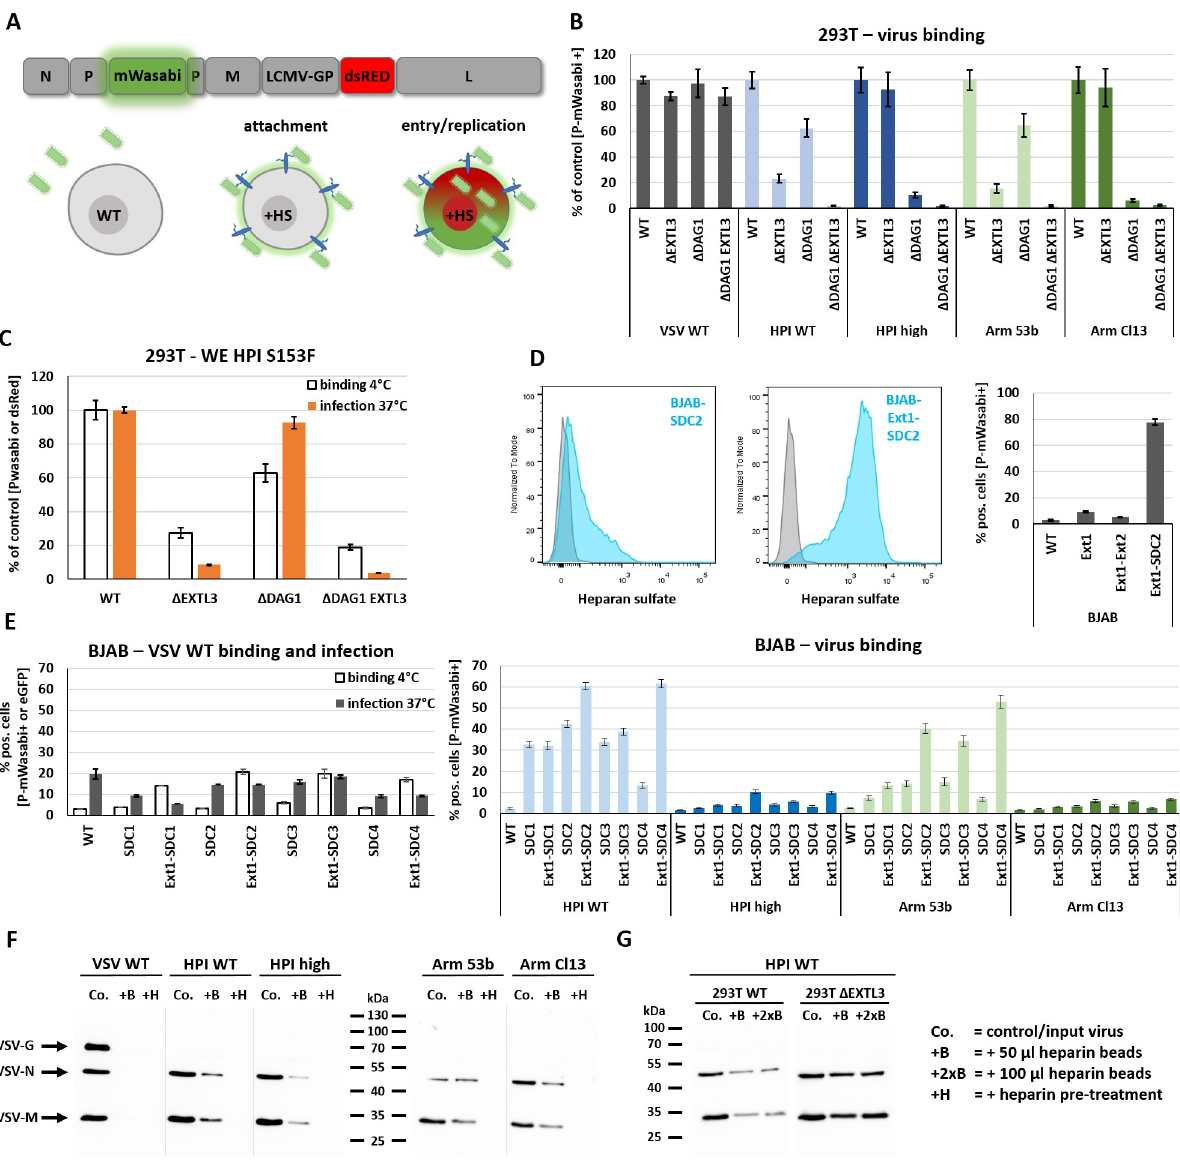
Fig 6. Proteoglycan expression restores HS expression on cell surface of BJAB cells and enables LCMV GP mediated virus attachment. (A) Schematic overview of a directly labelled VSV-GP construct encoding a P-mWasabi fusion construct and dsRed on 5 th position that allows to distinguish between attachment and virus entry/replication. Virus attachment was quantified by flow cytometry analysis. For attachment analysis, cells were incubated with directly labelled VSV-P-mWasabi-G or -GP variants for 30–45 min at 4˚C in a total volume of 50 μ l PBS or complete growth medium. Before measurement, samples were washed twice with PBS. Created with BioRender.com. (B) VSV-G and LCMV-GP mediated attachment of low or high affinity variants to 293T WT, Δ EXTL3 , Δ DAG1 , and Δ DAG1 EXTL3 cells. (C) Binding (4˚C for 30 min) and infection (MOI 1, 37˚C, 14 h p.i.) assay with 293T WT and variants for WE HPI S153F carrying the low affinity mutation described for WE2.2. (D) Flow cytometry analysis of HS expression in BJAB cells stably transduced with SDC2 or the combination of EXT1-SDC2 (left). GP-mediated (HPI WT) virus attachment to BJAB cells stably transduced with EXT1, EXT1-EXT2 or EXT1-SDC2 (right). (E) Different members of the syndecan family (SDC1–4) were tested alone or in combination with EXT1 in BJAB cells for their ability to enable VSV-G or LCMV-GP mediated attachment and infection. (F) In a pulldown assay, 50 μ l heparin-coated agarose beads (+B) were incubated with purified VSV WT or VSV-GP variants at 4˚C for 4 h under constant rotation. After four washing steps with PBS + 0.2% BSA, the beads were resuspended in 100 μ l RIPA buffer, incubated for 20 min on ice and boiled at 95˚C for 10 min after the addition of 4x SDS loading buffer. Western blotting was performed with anti-VSV serum (detecting VSV-G, -N, -M). co. = same amount of input virus used for incubation with heparin-coated agarose beads. (G) Bead-based pulldown assay performed with purified VSV-GP HPI WT produced on 293T WT or 293T Δ EXTL3 cells. Signal intensity was compared using 50 μ l or 100 μ l heparin-coated agarose beads to control for bead saturation effects. A pre-stained page ruler was used with the range of 10–180 kDa. Shown are the means ± SD of three